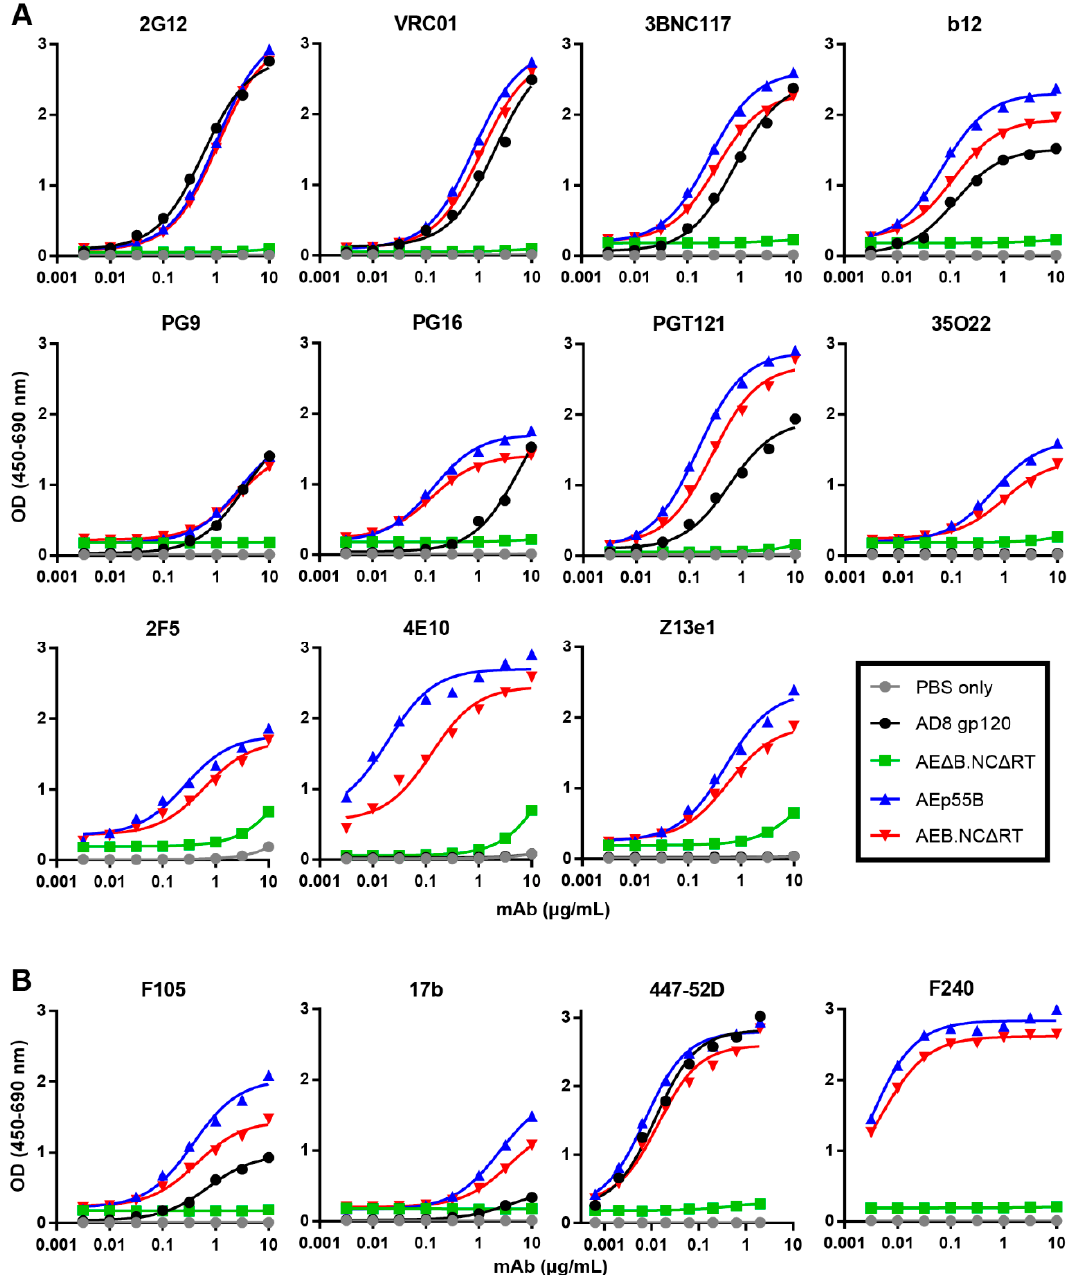
Figure 9. Comparison of anti-Env antibody binding to VLPs and soluble gp120. Representative ELISA binding curves of ( A ) bNAbs 2G12, VRC01, 3BNC117, b12, PG9, PG16, PGT121, 35O22, 2F5, 4E10, and Z13e1, and ( B ) poorly and non-neutralizing antibodies F105, 17b, 447-52D, and F240 to AD8 gp120, AEB.NC ∆ RT VLPs, AEp55B VLPs, AE ∆ B.NC ∆ RT VLPs, and a PBS only control. For both ( A ) and ( B ) VLP ELISAs were performed using concentrated AEB.NC ∆ RT and AEp55B VLPs equivalent to 250 ng / well purified AD8 gp120, as determined by anti-gp120 Western blotting. The loading of AE ∆ B.NC ∆ RT VLPs was equalized to the AEB.NC ∆ RT VLPs by p24 content, as